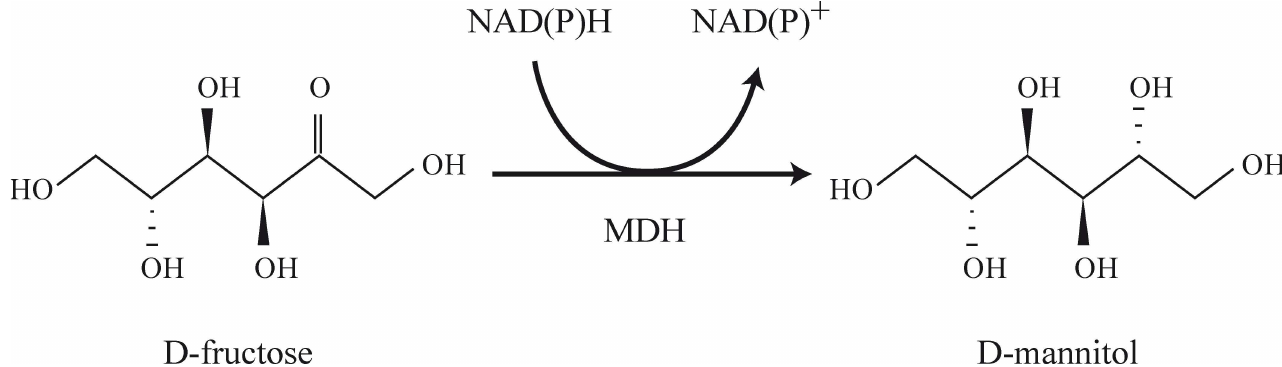
Fig 1. Conversion of fructose into mannitol catalyzed by the mannitol 2-dehydrogenase (MDH)